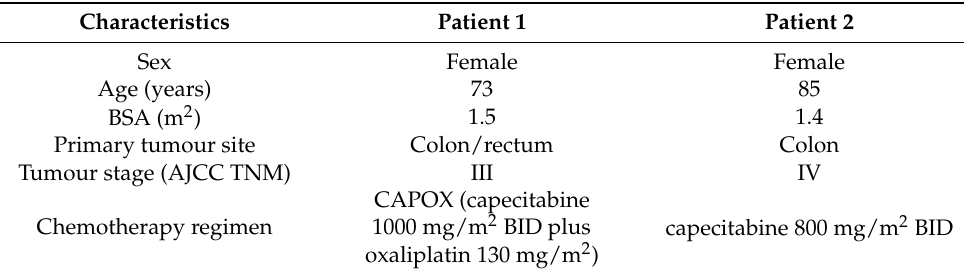
Table 1. Demographic and clinicopathologic characteristics of patients 1 and 2.